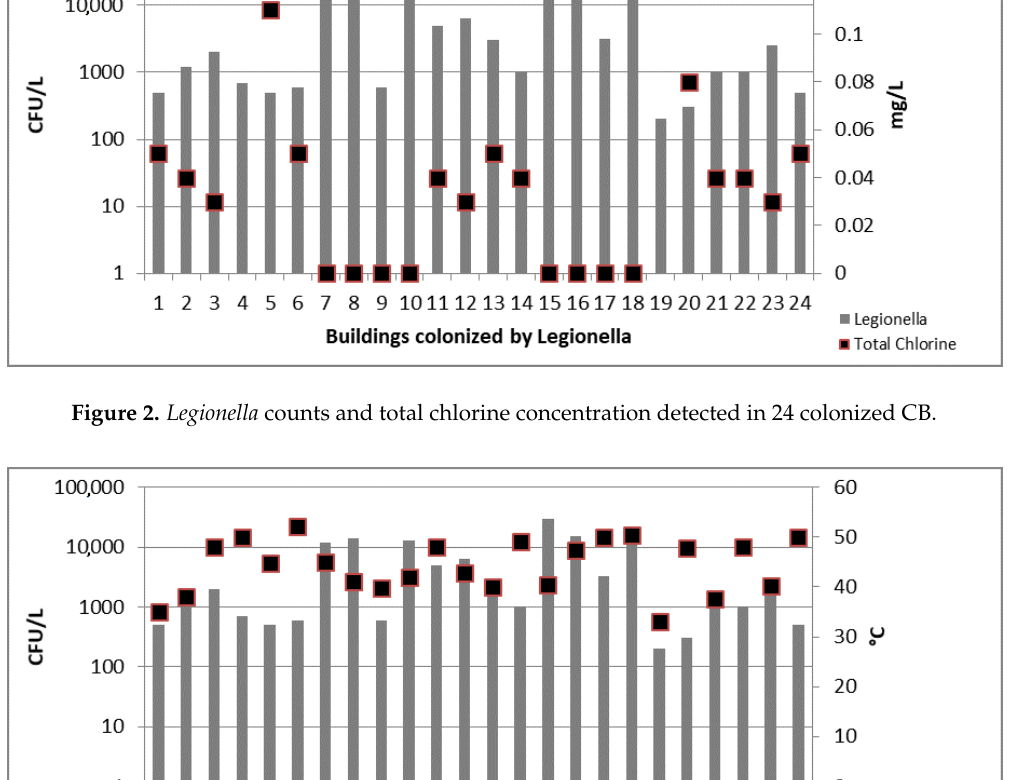
Figure 3. Legionella counts and temperature values detected in 24 colonized CB.